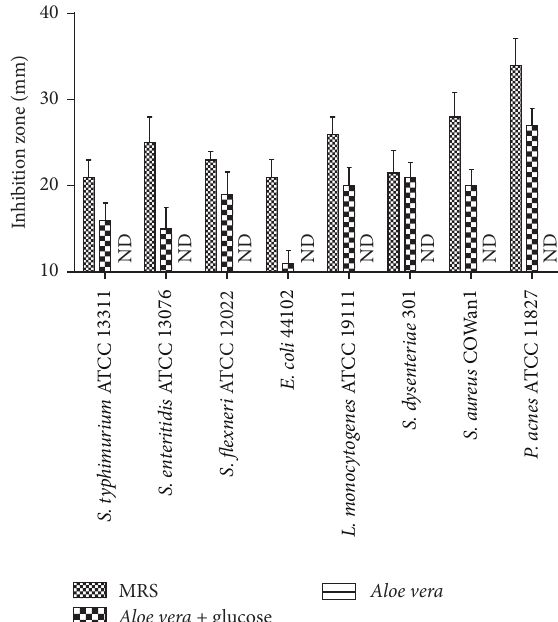
Figure 2: Antibacterial activities of L. plantarum against selected foodborne pathogens cultured in MRS, Aloe vera + glucose, and Aloe vera . Data are shown as the mean ±